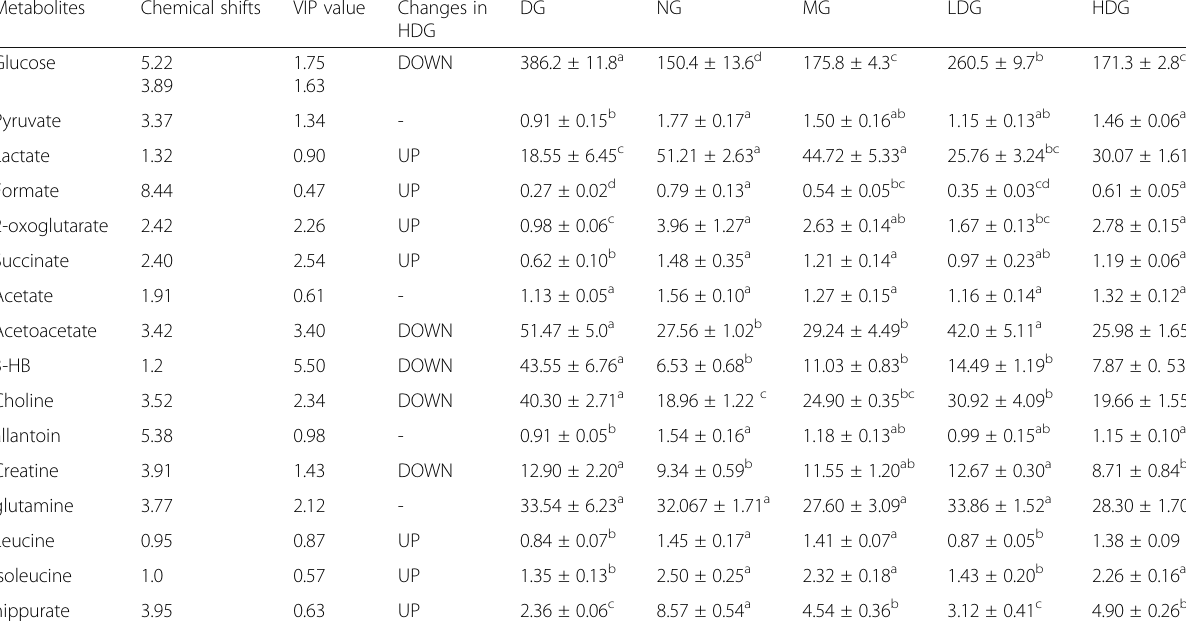
Table 4 Relative quantitative (mM) of significant discriminating metabolites of serum using Chenomx NMR Suite at week8 of